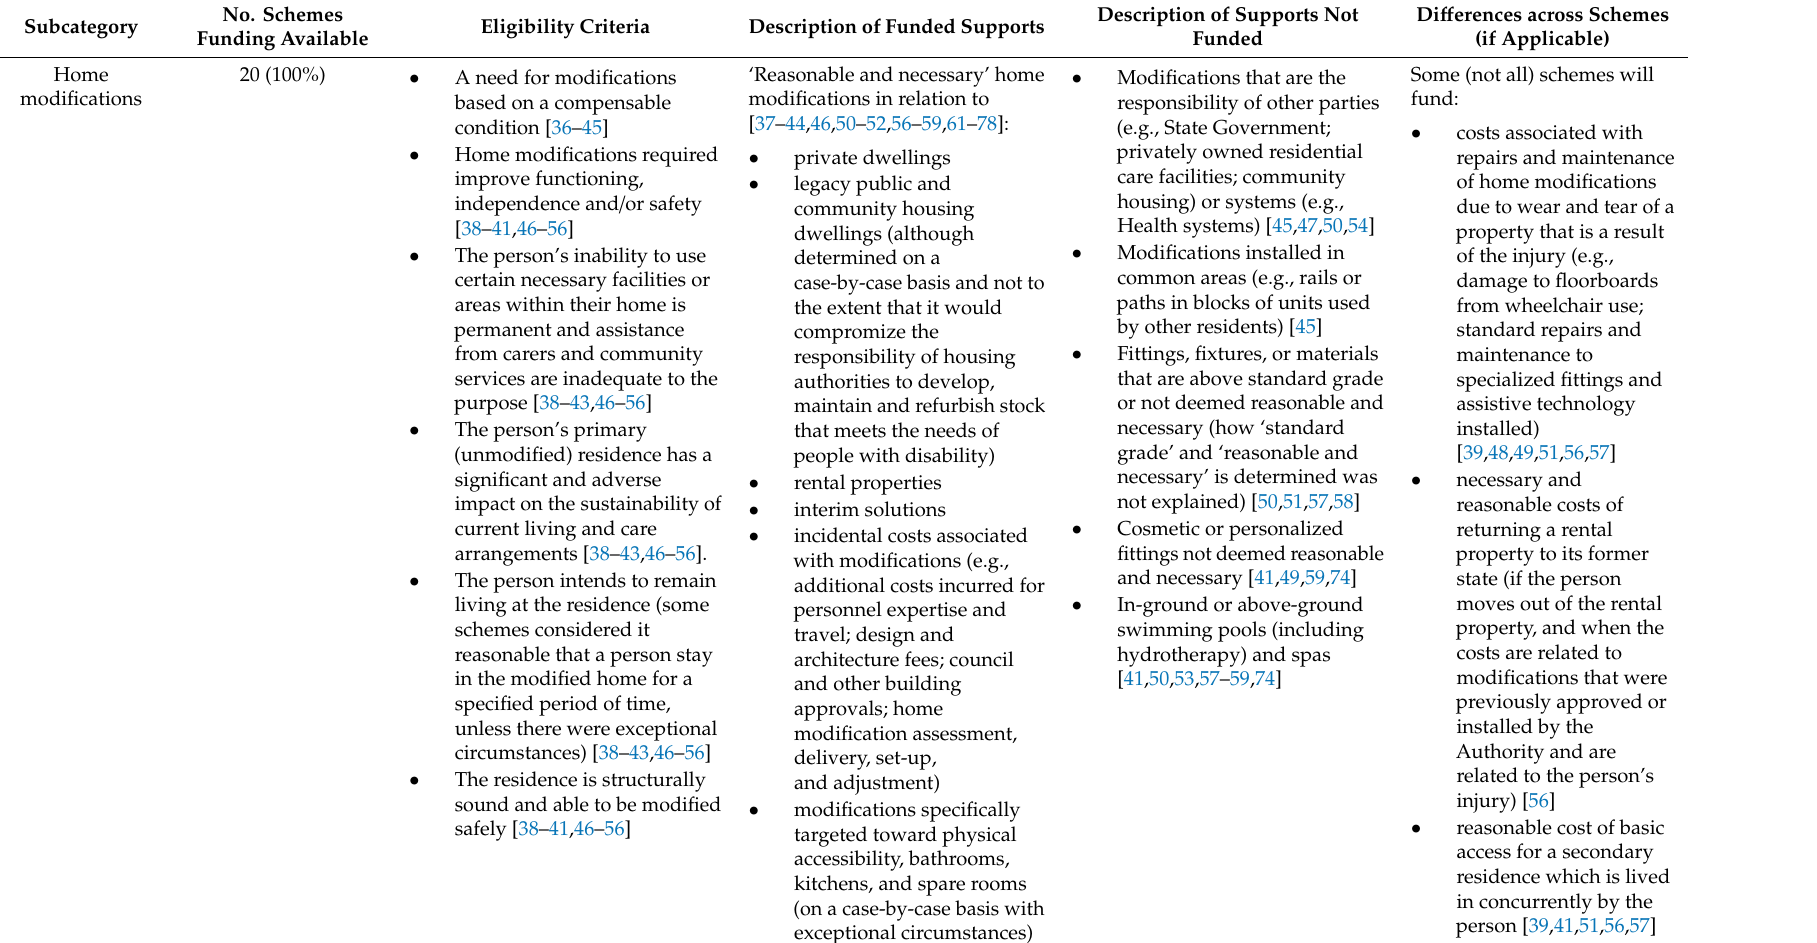
Table 2. A Comparison of Infrastructure Funding across the